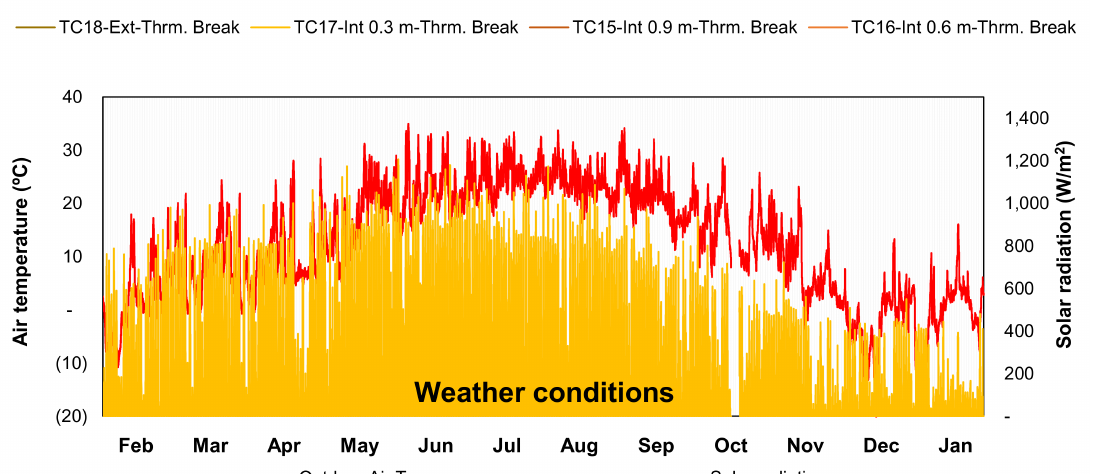
Figure A3. Experimental data for balcony pair